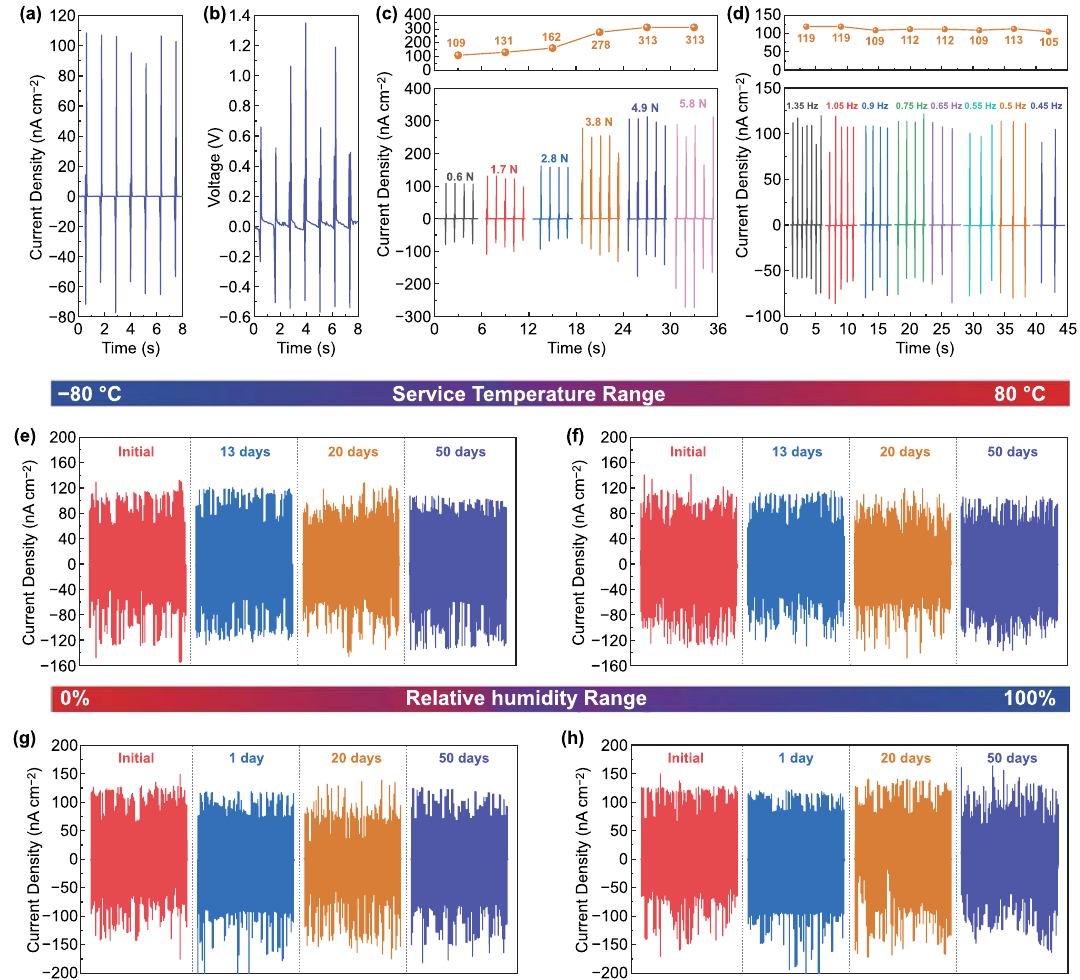
Fig. 3 a Density of I sc and b V oc of the PENG. The density of I sc and the output trend of PENG based on N doped 4H‑SiC NHAs under different external stimulus: c various forces and d various frequencies. The long‑term stability of as‑constructed PENG within up to 50 days under differ‑ ent temperatures and RHs: e ‑80, f 80 °C, g 0% RH, and h 100%